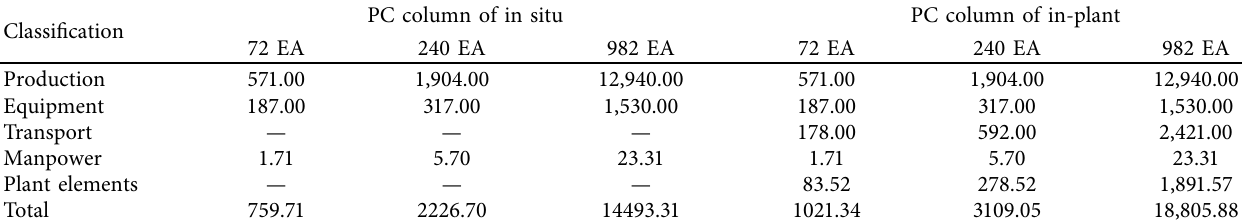
Table 7: CO 2 emissions of precast concrete column based on in situ production and in-plant